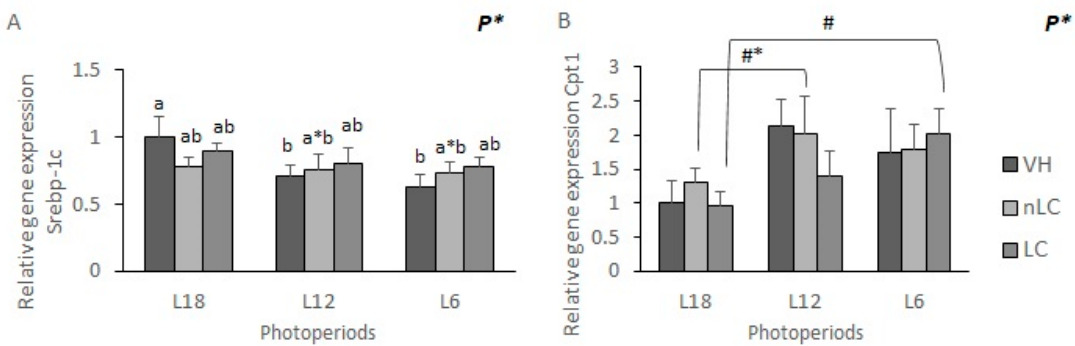
Figure 2. Gene expression of liver protein and enzyme. The mRNA levels of sterol regulatory element-binding protein 1 (srebp-1c) ( A ) and Carnitine palmitoyltransferase 1 α (cpt1 α ) ( B ), of male Fischer 344 rats treated for 7 weeks with vehicle (VH), non-local cherries (nLC) or local (LC) and exposed to different photoperiods (short, L6; standard, L12; long, L18). Values expressed as mean ± SEM ( n = 8). The values were normalized by the L18-VH group. P, photoperiod effect (two- way ANOVA, p <0.05). Different letters above the bars indicate significant differences ( p <0.05) (post-hoc DMS, one-way ANOVA). # indicates effect of the same treatment compared between different photoperiods (Student´s t- test). * indicates trend (0.05 < p <1).